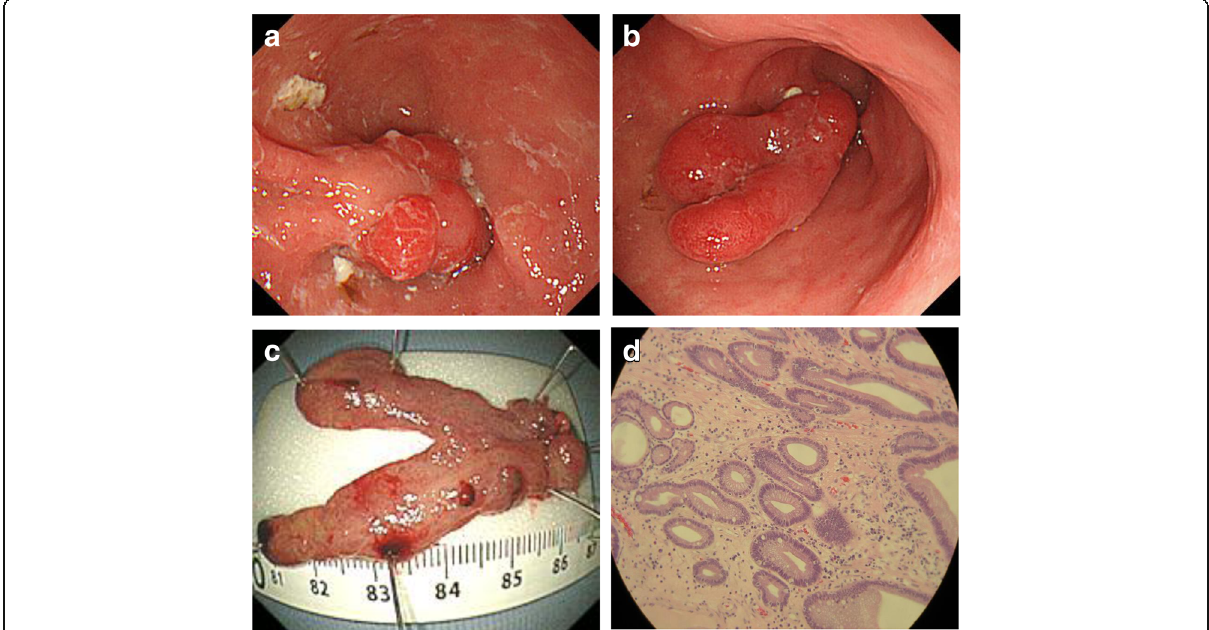
Fig. 1 Gastric polyp. Endoscopic examination revealed a a pedunculated polyp of the gastric antrum that fit into the pylorus and b a pedunculated